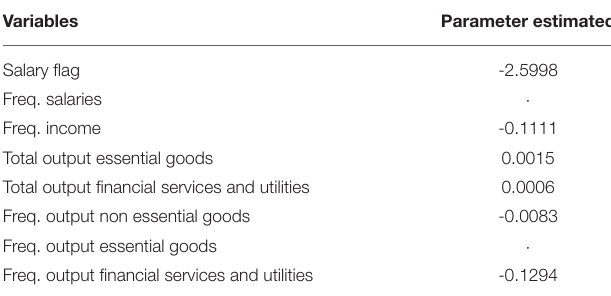
TABLE 4 | Important variables selected by Lasso Model on textual